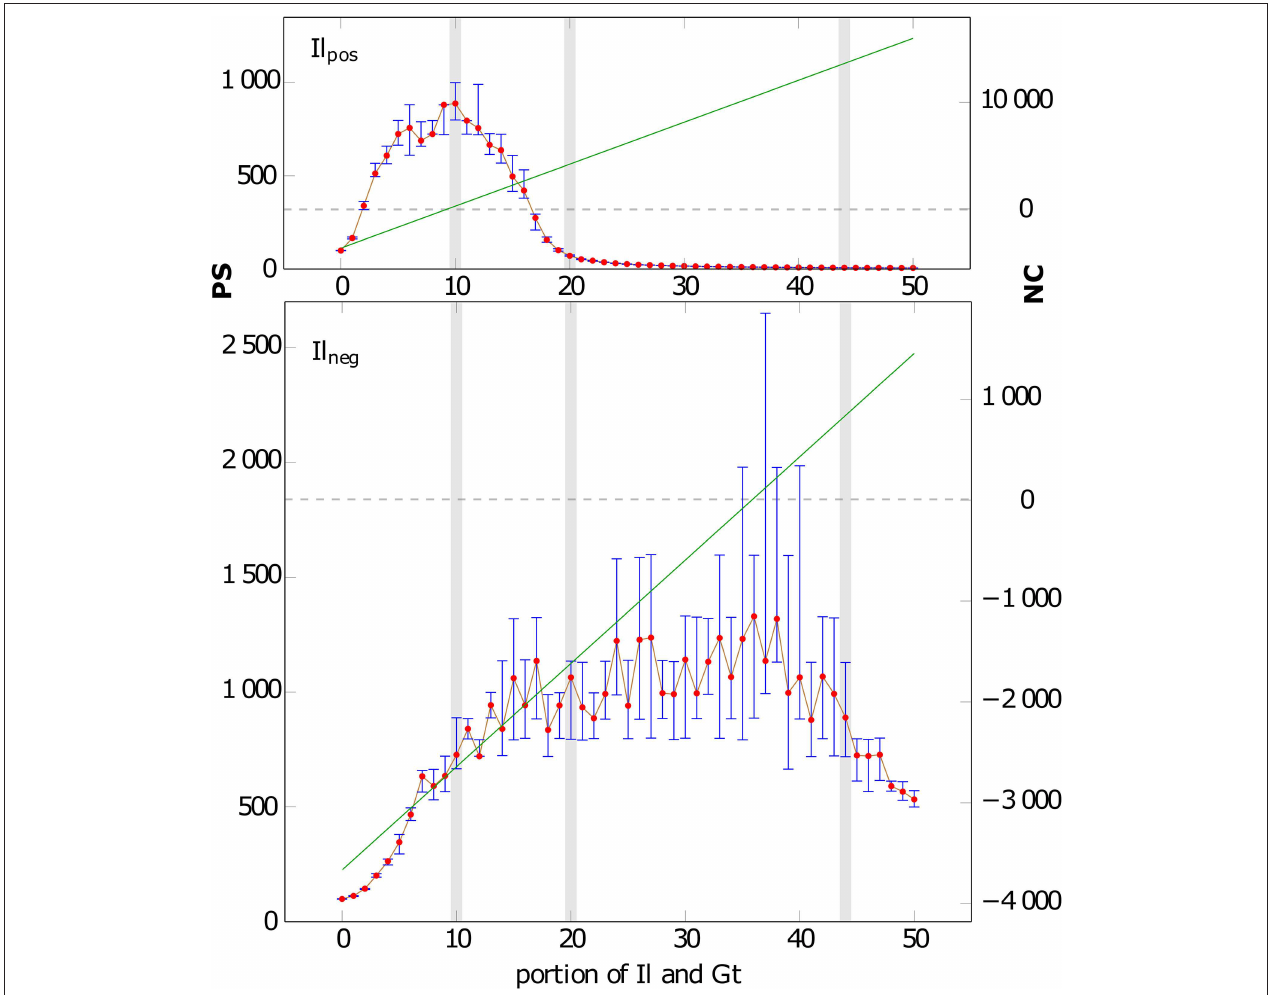
FIGURE 1 | Average particle sizes (PS) for various compositions of the solid after 1,000 CAM steps: X-axis: number denotes the (equal) portions of Il and Gt, the remaining portion is Qz (i.e., 10 represents a composition of 10% Gt, 10% Il, and 80% Qz particles). ( Top ) Il is positively charged (Il pos ), ( Bottom ) Il is negatively charged (Il neg ). The red dots show the median of 10 runs, the blue bars indicate the lower and upper quartile of the 10 runs. The green lines depict the net electric charge (NC) of the system and correspond to the second y-axis. The intersection of the gray dashed line and the green line marked the NC of zero and the highest PS in both systems. The gray shaded areas correspond to the three compositions shown in Figure 2